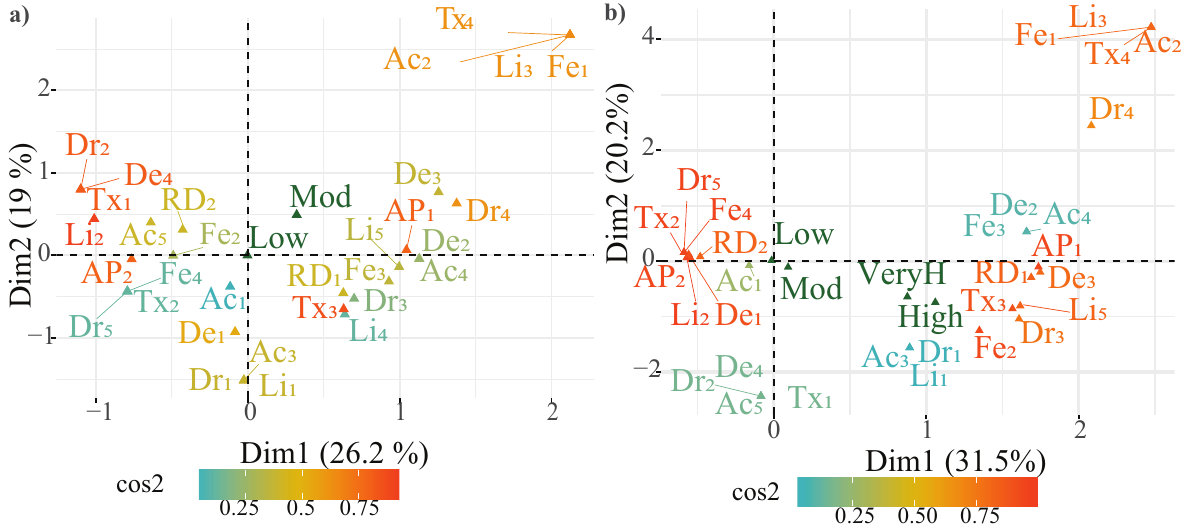
Figure 8. MCA factor results with a quality color description (quadratic cosine) for ( a ) ILI1-Inner and ( b ) ILI1-Outer. Labels are explained in Table